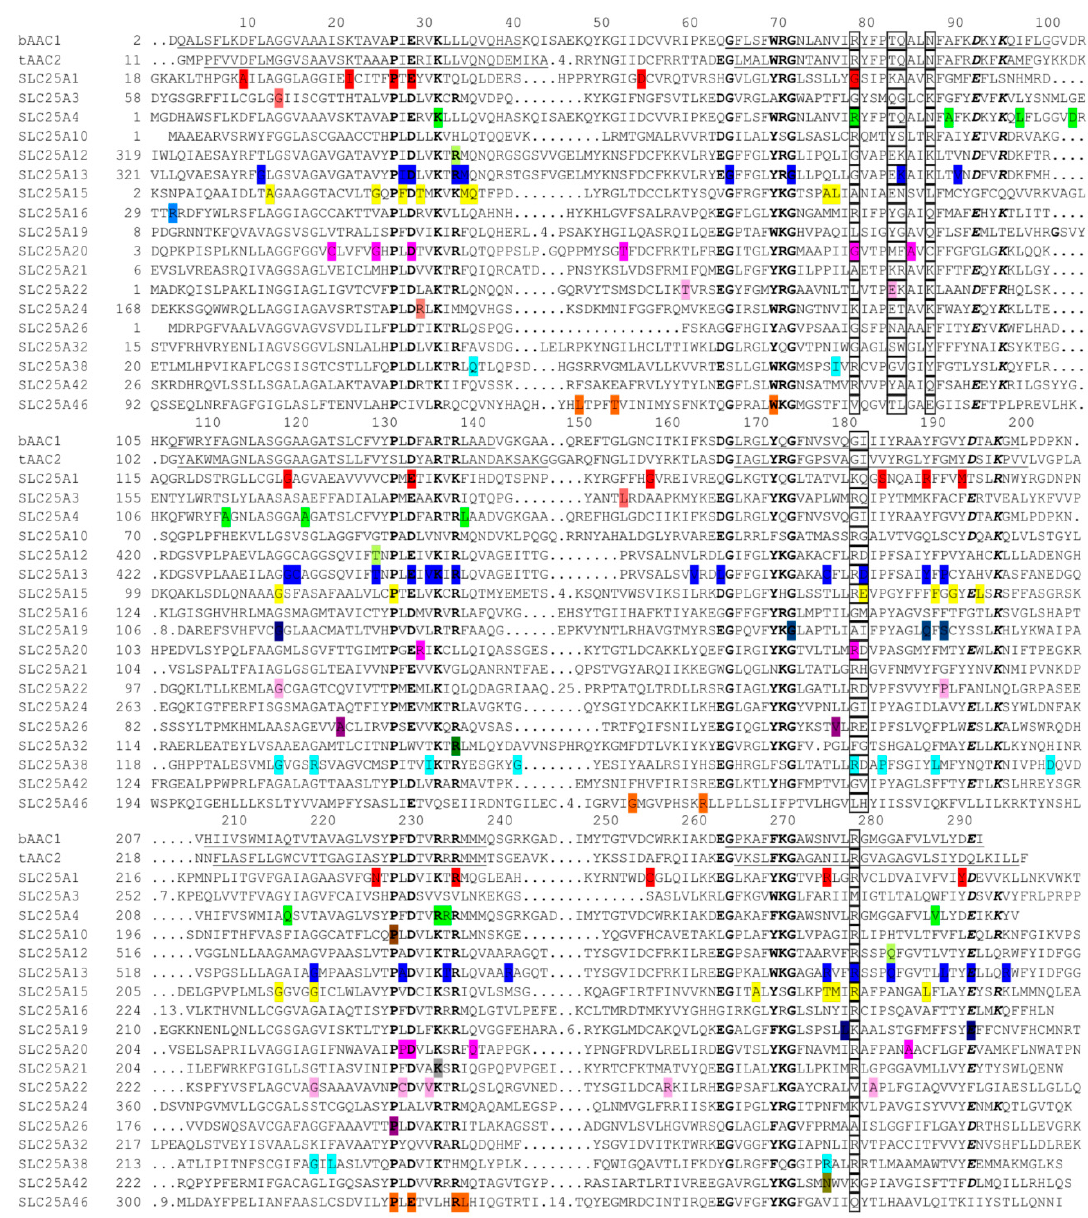
Figure 1. Multiple sequence alignment of mitochondrial carriers showing the position of disease-causing point mutations. The protein sequences of the 18 MCs found to have disease-causing point mutations are aligned against the sequences of bovine AAC1 (bAAC1 with numbering) and Thermothelomyces thermophila AAC2 (tAAC2) whose 3D-structures have been determined (Figure 2). Sequences of the transmembrane helices are underlined, the conserved residues of the SMSs are in bold, the charged residues of the cytoplasmic gate are in italics, and the contact points I, II, and III residues on the first, second, and third row of the alignment, respectively, are boxed. The numbers inside the alignment indicate missing residues. One color for each MC indicates the positions of the single point mutations associated with disease, and the top color in each position in the alignment corresponds to the colored positions in Figure 2.